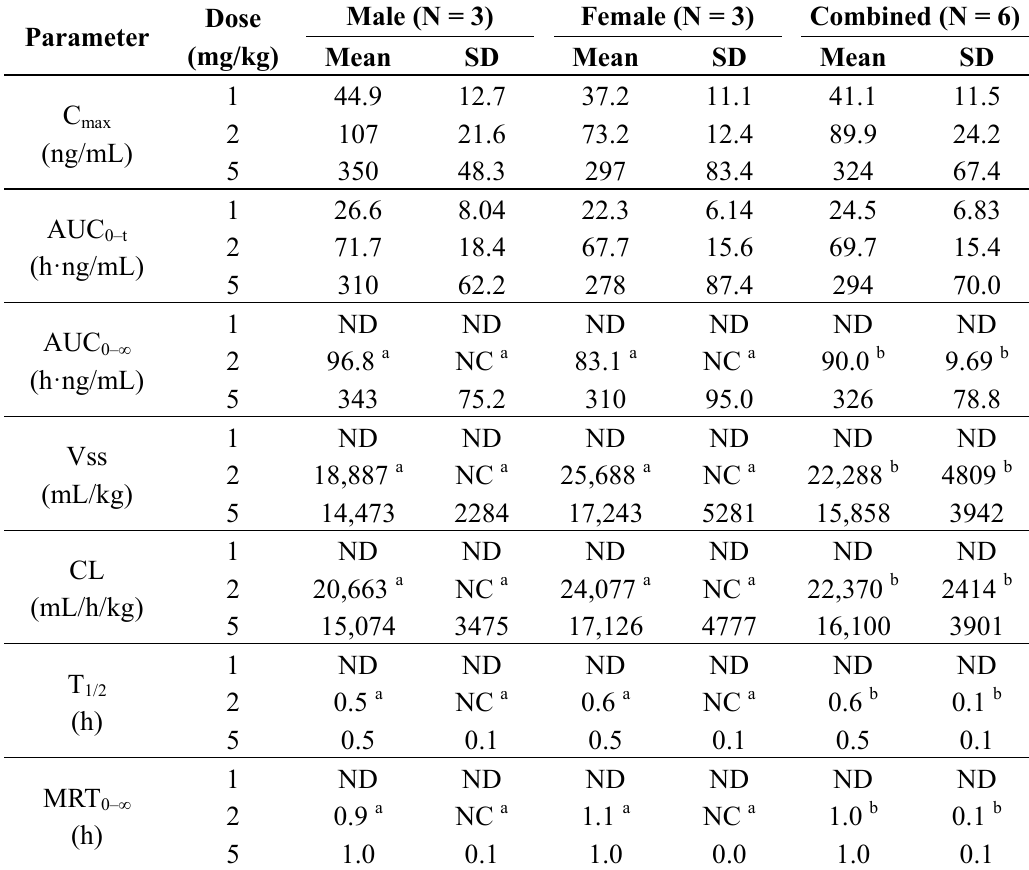
Table 3. Pharmacokinetic Parameters of BMEDA in Beagle Dogs after Intravenous Injection of BMEDA at 1, 2 and 5